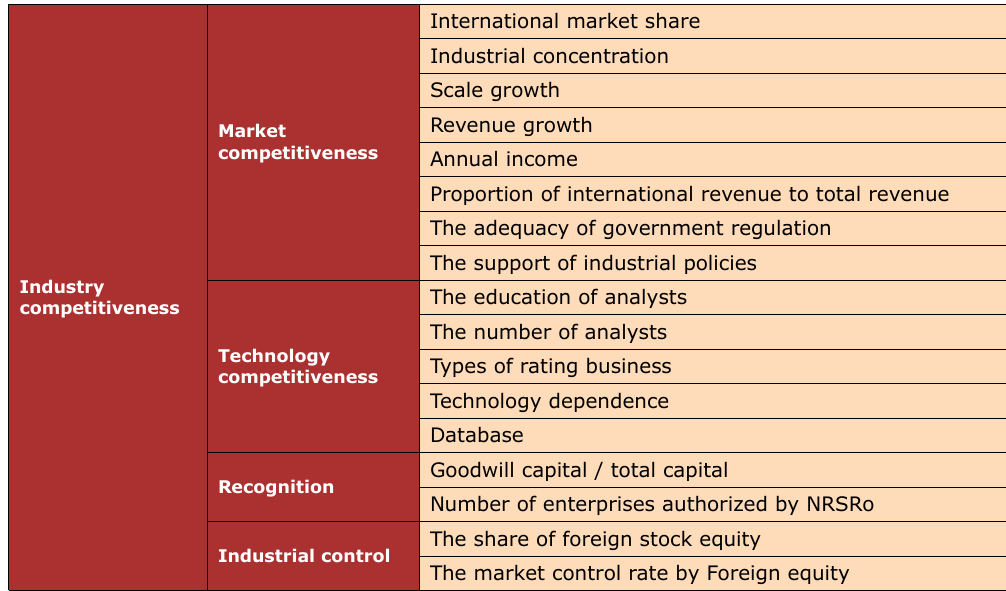
Table 1. Scoring Criteria